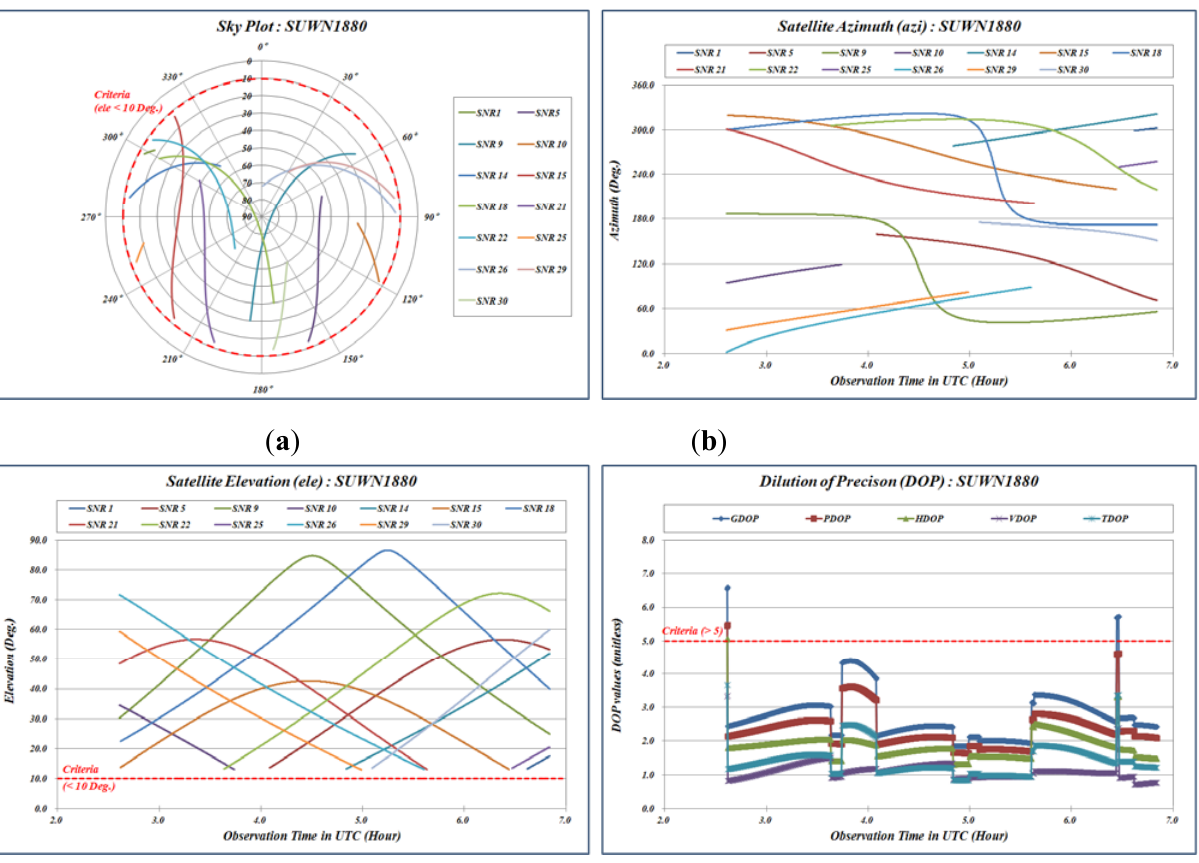
Figure 4. Quality control indicators related to geometric arrangement. ( a ) Sky plot of observed satellite. ( b ) Satellite azimuths. ( c ) Satellite elevations. ( d ) DOP